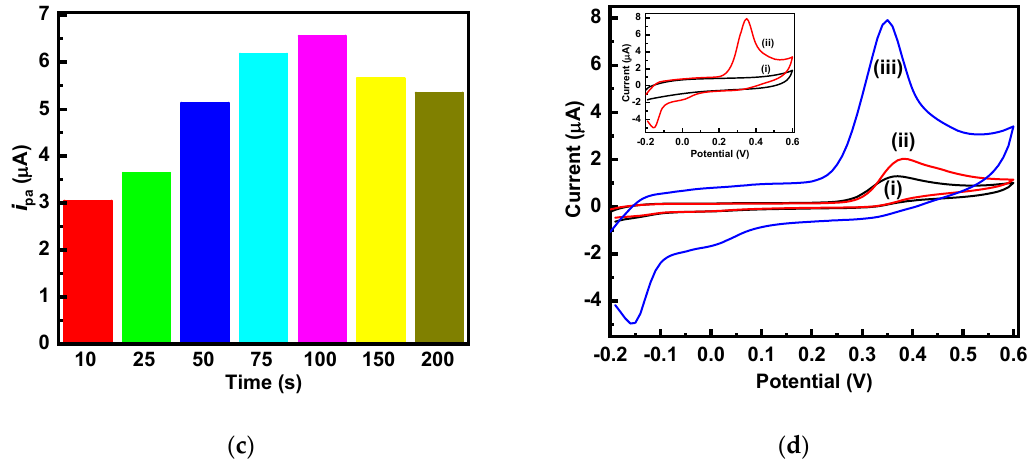
Figure 2. ( a ) Amperometric current response of 5-HT oxidation using various applied potential against di ff erent times. ( b ) CVs of g-C 3 N 4 nanosheets were carried out at a constant applied potential of 1.75 V against di ff erent times. ( c ) The corresponding current response of 5-HT oxidation against di ff erent times. ( d ) CVs of (i) bare GCE, (ii) bulk g-C 3 N 4 , and (iii) g-C 3 N 4 nanosheets in 0.1 M PBS (pH 7.0) containing 30 µ M 5-HT at a scan rate of 50 mVs − 1 . Inset: CV curves of g-C 3 N 4 nanosheets in